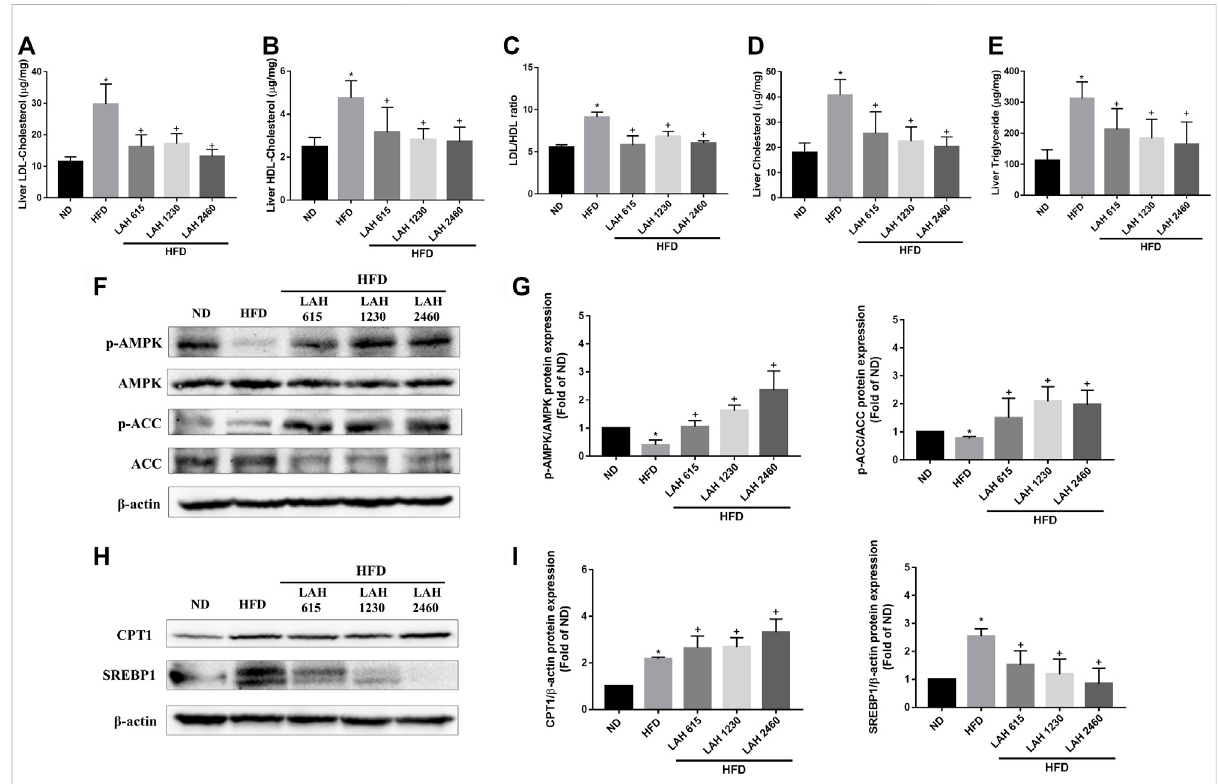
FIGURE 7 LAH treatment ameliorates HFD-induced hepatic lipids accumulation via AMPK-SREBP1 pathway. Liver content of (A) LDL, (B) HDL, (C) LDL/ HDL ratio, (D) CHOL, and (E) TG in the ND, HFD, or HFD containing 615 mg/kg, 1230 mg/kg, and 2460 mg/kg LAH extract groups are shown ( n = 10pergroup). (F) PhosphorylatedAMPK,AMPK,PhosphorylatedACC,ACCproteinlevelsbywesternblotanalysis. (G) Phospho-AMPKandphospho- ACC protein expression was normalized to total AMPK and ACC, respectively. (H) CPT1, and SREBP-1 protein levels by western blot analysis. (I) CPT1 and SREBP1 protein expression was normalized to β -actin. Values are expressed as mean ± SD (n = 3/group). * p < 0.05, compared with ND group. + p < 0.05 compared with HFD